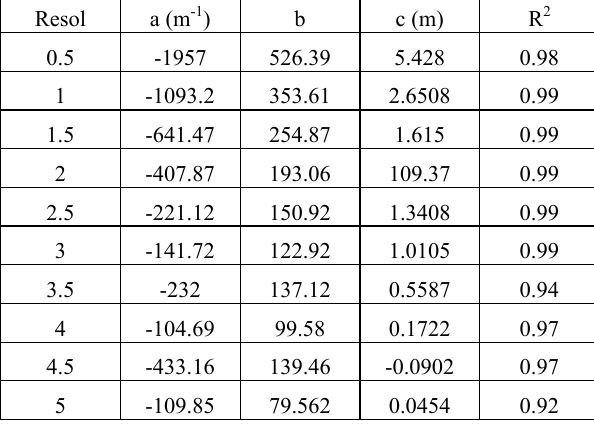
Table 2. Fitting parameters to equation of the form: difference = a·std 2 + b·std +